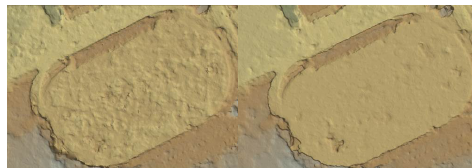
Figure 11 Comparison of DSM obtained by three methods in weak texture area (the upper left is the reference image, and the upper right, lower left and lower right correspond to methods ① , ② and ③ respectively)